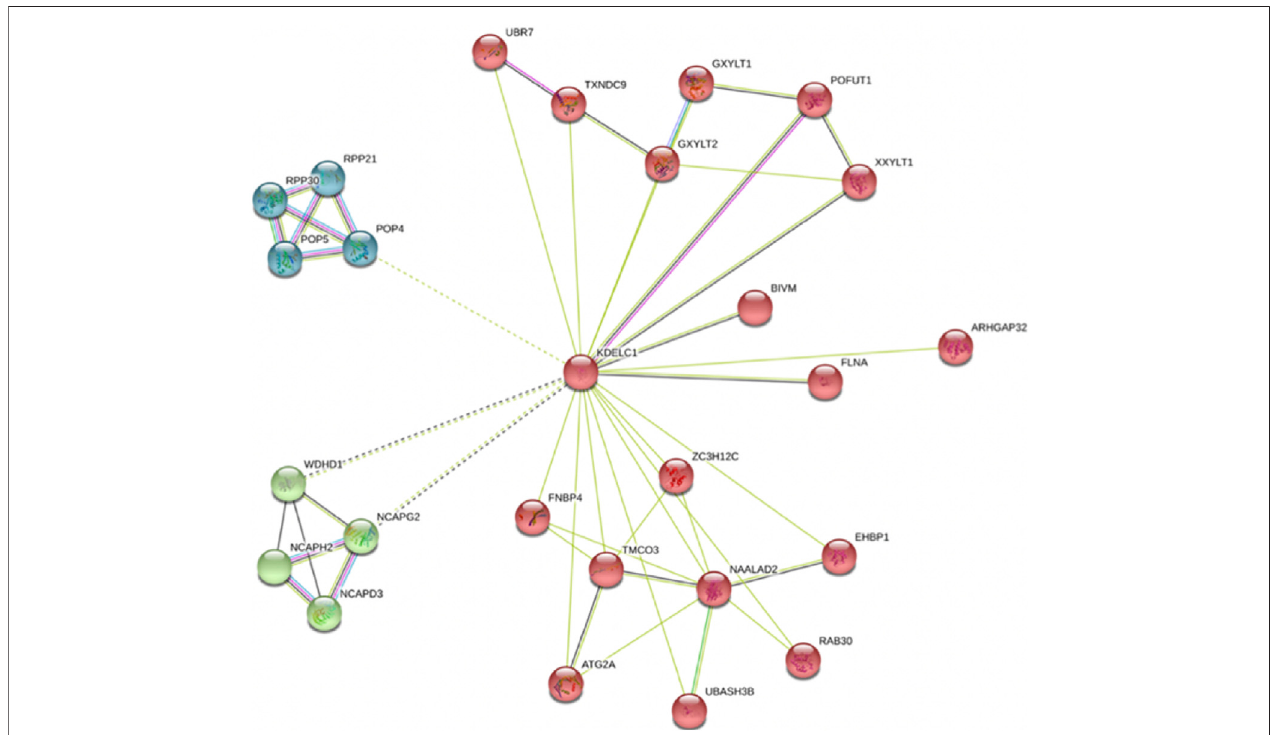
FIGURE 4 | KDELC1 protein network extracted from STRING